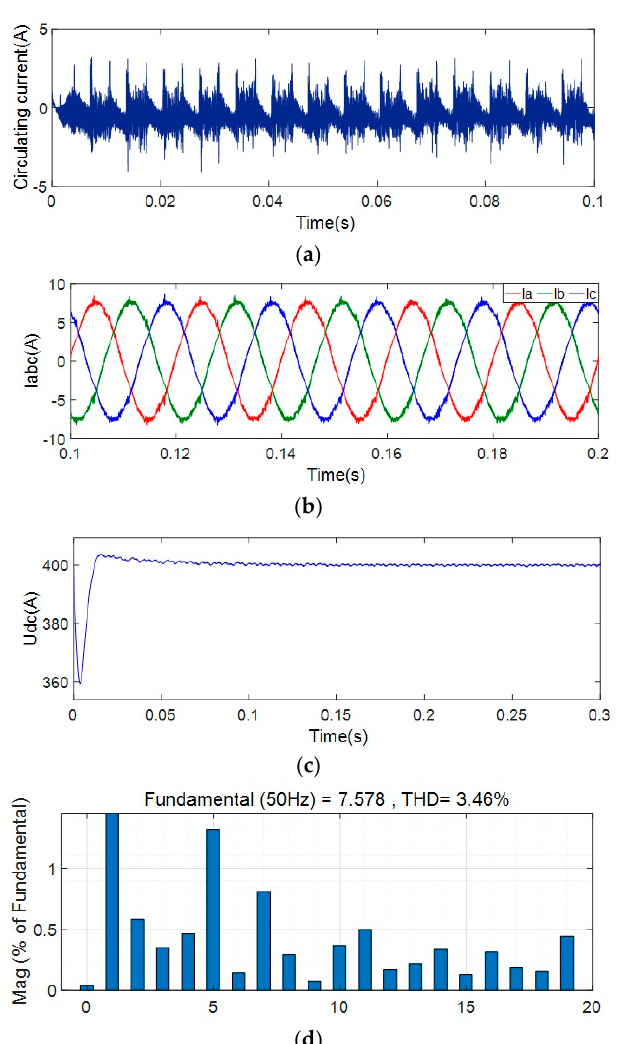
Figure 13. The control scheme of the suppressing circulating current is not added under different conditions of positive and negative DC bus inductance of parallel modules ( a ) Positive DC bus circulating current. ( b ) AC side current. ( c ) DC side output voltage. ( d ) THD of AC side current.